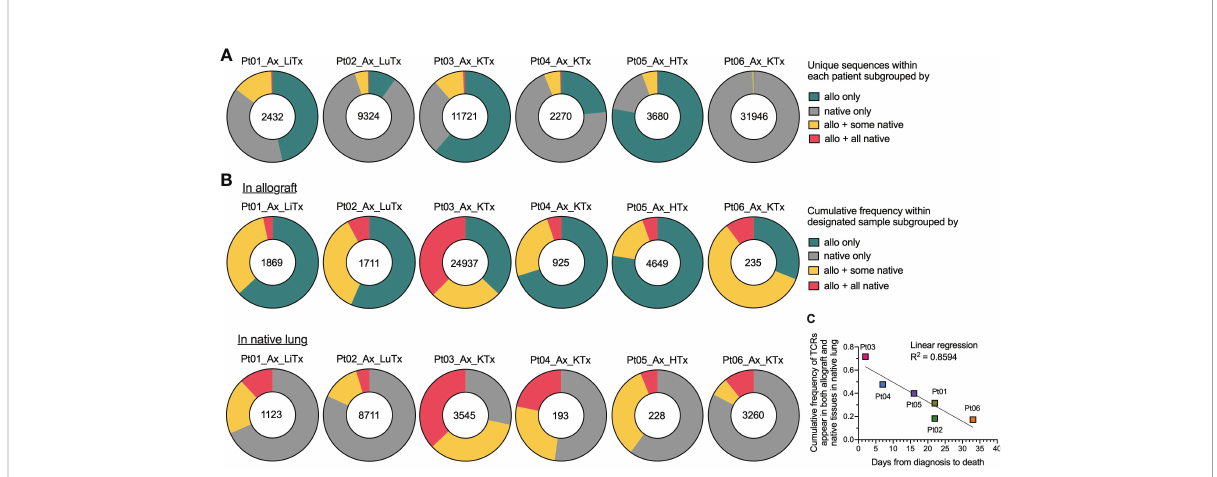
FIGURE 3 Broadness of TCR clonal distribution and its correlation with disease progression after COVID-19 diagnosis. (A) Quanti fi cation of the number of unique TCR sequences for each patient (shown in the center of each pie chart) present in the allograft ( “ allo ” ) only, native tissue ( “ native ” ) only, “ allo + some native ” tissues, and “ allo + all native ” tissues. (B) Quanti fi cation of the cumulative frequency of TCR sequences within the allograft (upper panel) or native lung (lower panel) of each patient subgrouped by their presence in “ allo only ” , “ native only ” , “ allo + some native ” and “ allo + all native ” . The number of total productive TCR templates in the allograft (upper panel) or native lung (lower panel) of individual patient is shown in the center of each pie chart. Cumulative frequency was calculated as a percentage of all sequences weighted by copy numbers in designated populations. (C) Association between cumulative frequency of TCR sequences appeared in both allograft and native tissues within native lung and days from COVID-19 diagnosis to death is shown. Linear regression R 2 =